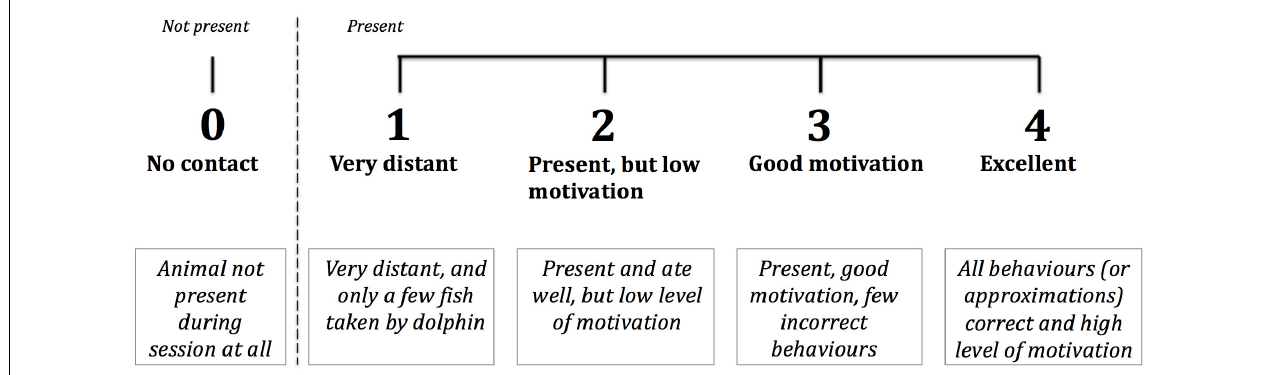
FIGURE 1 | 5-point Likert scale used by trainers in four facilities to score each dolphin’s Willingness to Participate ( WtP ) in multiple daily sessions over the year- long